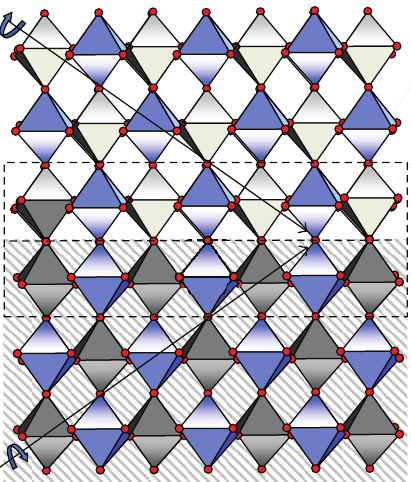
Figure 4: Tilt twin region in NBT/NBT-BT showing two rhom- bohedral twins with different polarization directions meeting in a tetragonal tilt twin region, as shown by the dashed box. Modified version reproduced with permission from